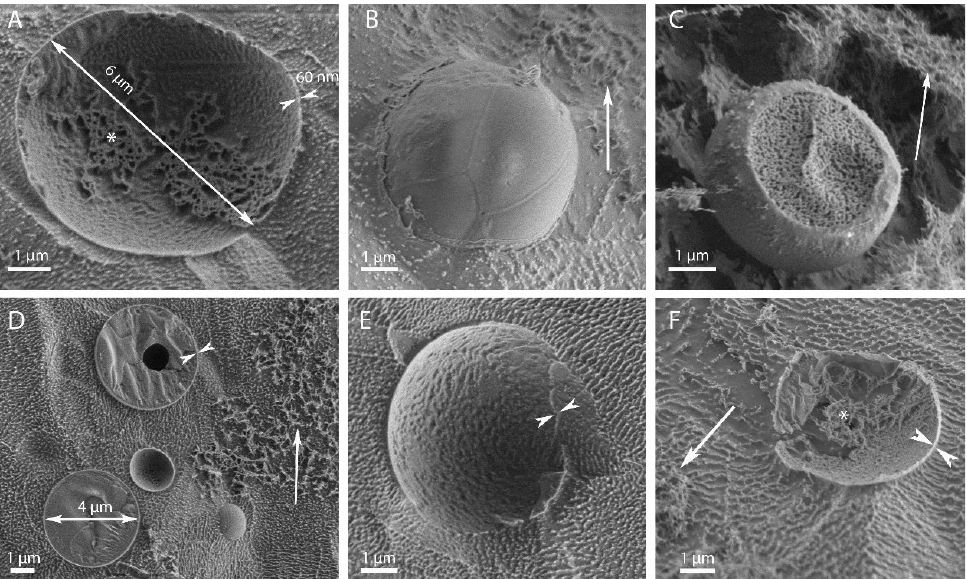
Figure 2. Cellulose microcapsules containing TY ( A – C ) or EU ( D – F ) at a 1:8 ratio, fabricated by HPH under ( A , D ) 5000 psi, ( B , E ) 10,000 psi, or ( C , F ) 20,000 psi. The outward and inward pointing double arrows indicate the capsule diameter and shell thickness, respectively. The single arrow points to the cellulose hydrogel particles in the background and the asterisks mark the cellulose network at the inner shell side after the EO core was detached during specimen fracture.